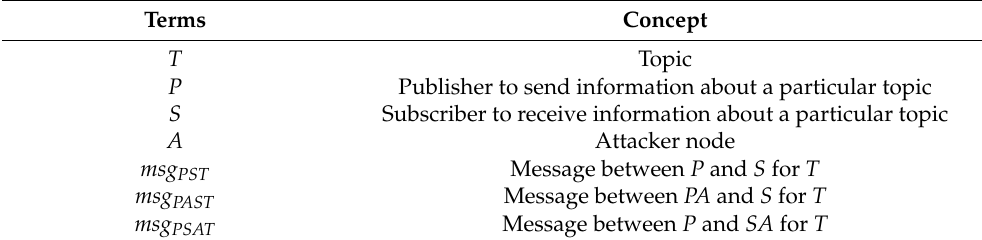
Table 1. The terms used in